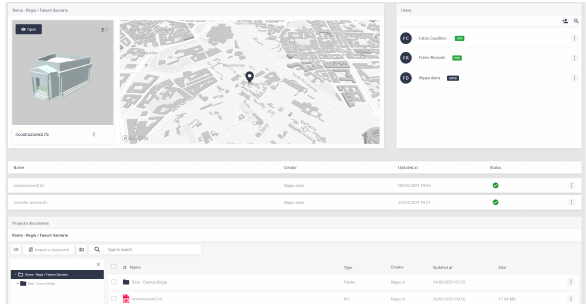
Figure 11 . BIMData platform interface: the viewer to the left; location at the center; users to the right; upload version and data below.